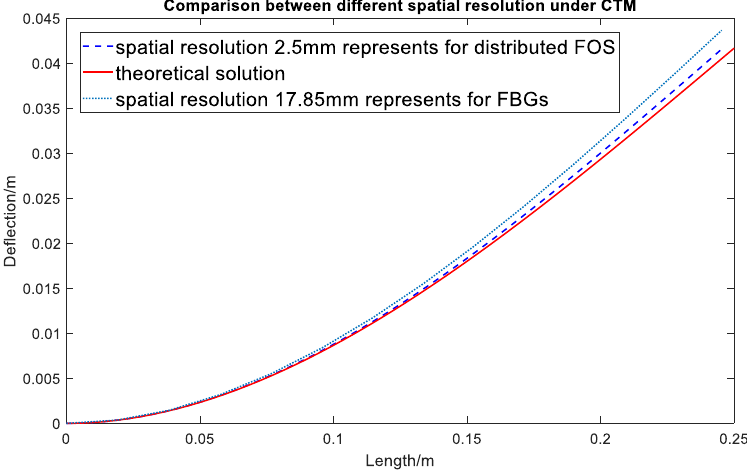
Figure 9. Comparison between different spatial resolutions in coordinate transformation method.